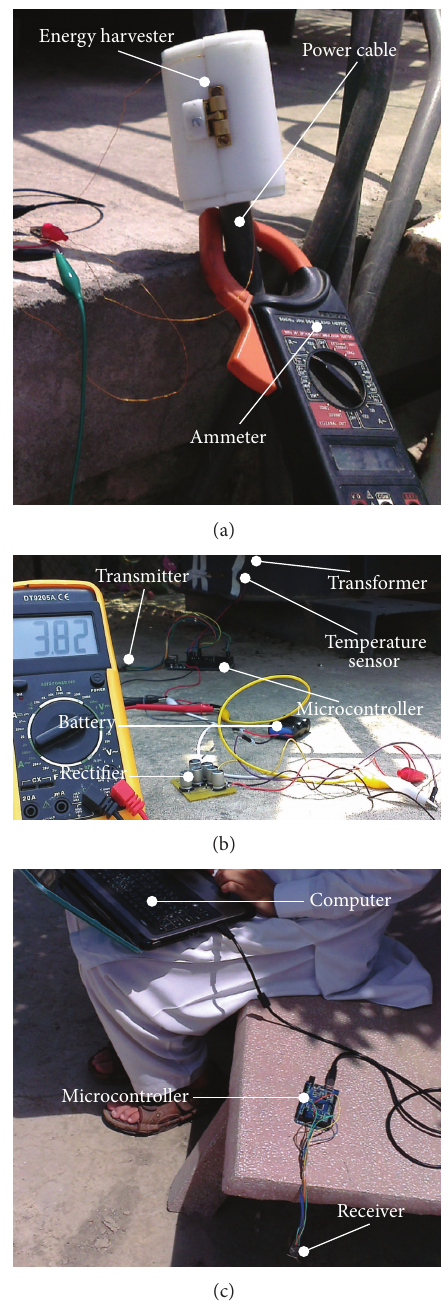
Figure 26: Photographs during wireless temperature monitoring of electrical transformer: (a) developed energy harvester mounted over output power line, (b) rectifier, rechargeable battery, and wireless sensor module integrated with the energy harvester, and (c) receiver connected with notebook computer through